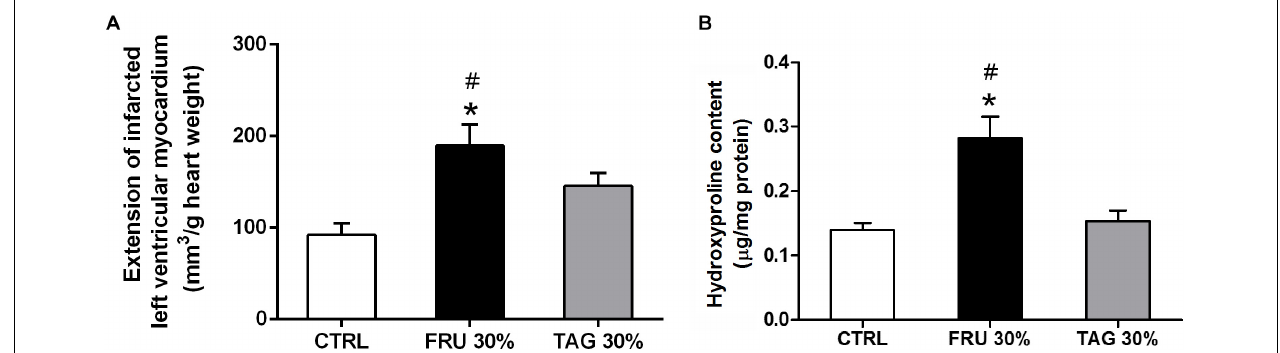
FIGURE 3 | Impact of chronic sugar exposure on myocardial damage. (A) Extension of myocardial infarct size. The extension of infarcted left ventricular myocardium was evaluated on hearts stained with nitro-blue tetrazolium (NBT) after left anterior descending (LAD) occlusion. Data are means ± SD for 6 (CTRL and TAG 30% groups) and 5 (FRU 30% group) animals per group. (B) Hydroxyproline content in heart tissue homogenates. Data are means ± SD for four samples per group; * p < 0.05 vs. CTRL; # p < 0.05 vs. TAG 30%.